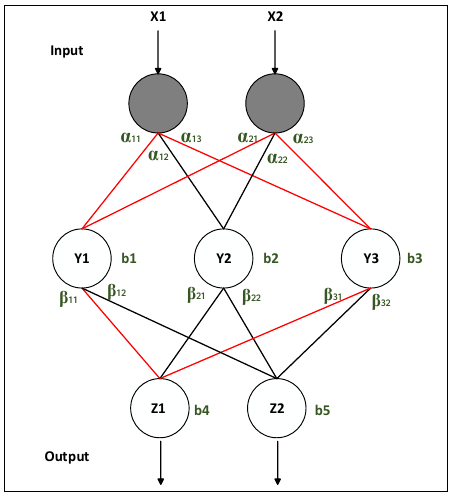
Algorithm 1 requires input image 𝑋 , neuron 𝑝 and